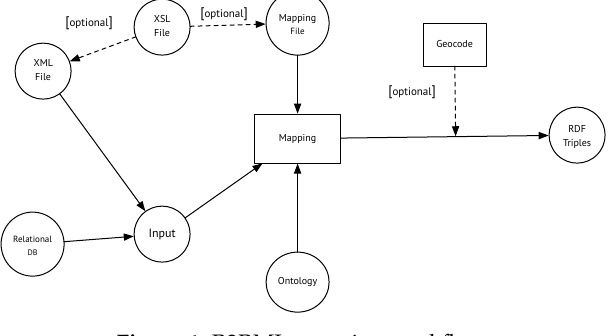
Figure 1. R2RML mapping workflow.